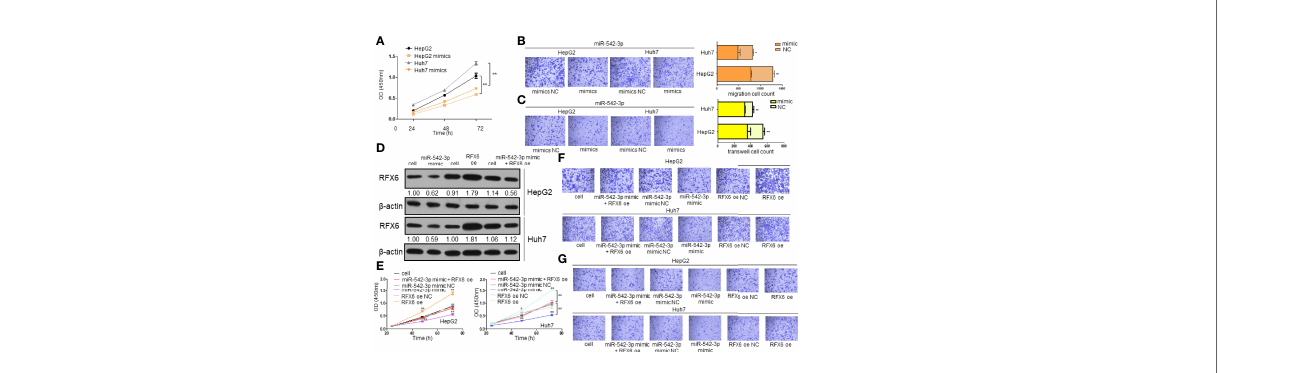
FIGURE 6 | Downregulation of RFX6 by miRNA-542-3p affects the invasion and oncogenesis of hepatocellular carcinoma cells. (A) Overexpression of miR-542-3p reduced the proliferation of liver cancer cells. The cell number was determined using the CCK-8 assay. Data were represented as mean ± standard deviation (SD), n = 3, ** p < 0.01. (B) miR-542-3p overexpression could signi fi cantly suppress the migration of HepG2 and Huh7 cells. Data were represented as mean ± standard deviation (SD), n = 3, * p < 0.05, ** p < 0.01. (C) Overexpression of miR-542-3p reduced the invasion ability of liver cancer cells. Data were represented as mean ± standard deviation (SD), n = 3, ** p < 0.01. (D) Overexpression of RFX6 could reverse the protein level of RFX6 inhibited by miR-542-3p. (E) Proliferation of liver cancer cells when rescuing RFX6 expression. The cell number was determined using the CCK-8 assay. Data were represented as mean ± standard deviation (SD), n = 3, *p < 0.05, ** p < 0.01. (F) Migration ability of liver cancer cells before and after rescuing the expression of RFX6. (G) Rescuing the expression of RFX6 affected the invasion ability of HepG2 and Huh7